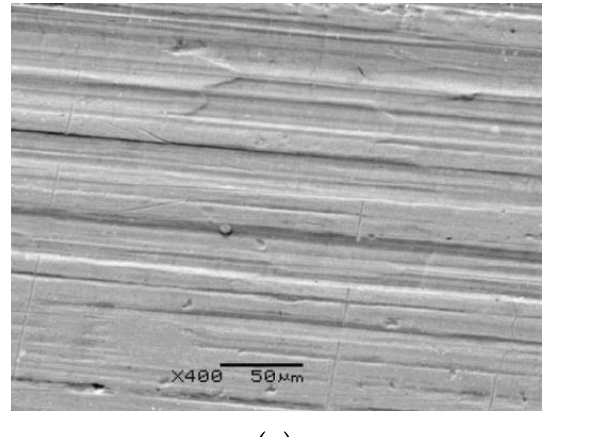
( b ) Figure 7. Surface topography of PA2 aluminium alloy specimens after ice-water jet treatment (p w = 35 MPa, 𝑚̇ 𝐿 = 208 k g·h −1 , l 2 = 250 mm, κ = 90°): ( a ) Scanning electron microscope image (400×magnification); ( b ) Isometric image.